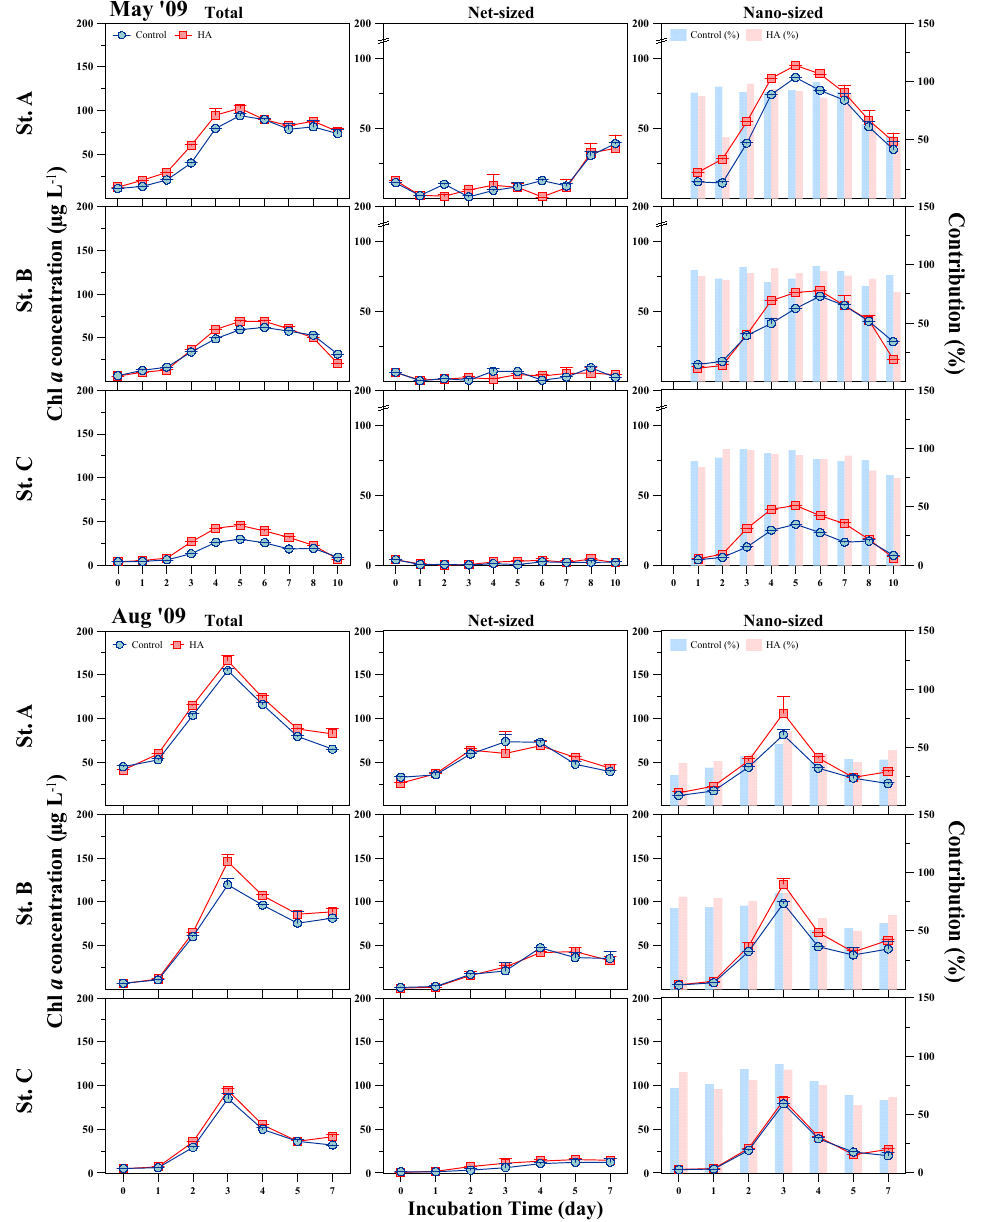
Figure 2. Size-fractionated chl a concentration ( µ g L − 1 ) and contribution percentage (%) of nanosize class during the mesocosm experiments (control vs. HA treatment) for water samples collected at Sts. A, B, and C in May and August 2010.